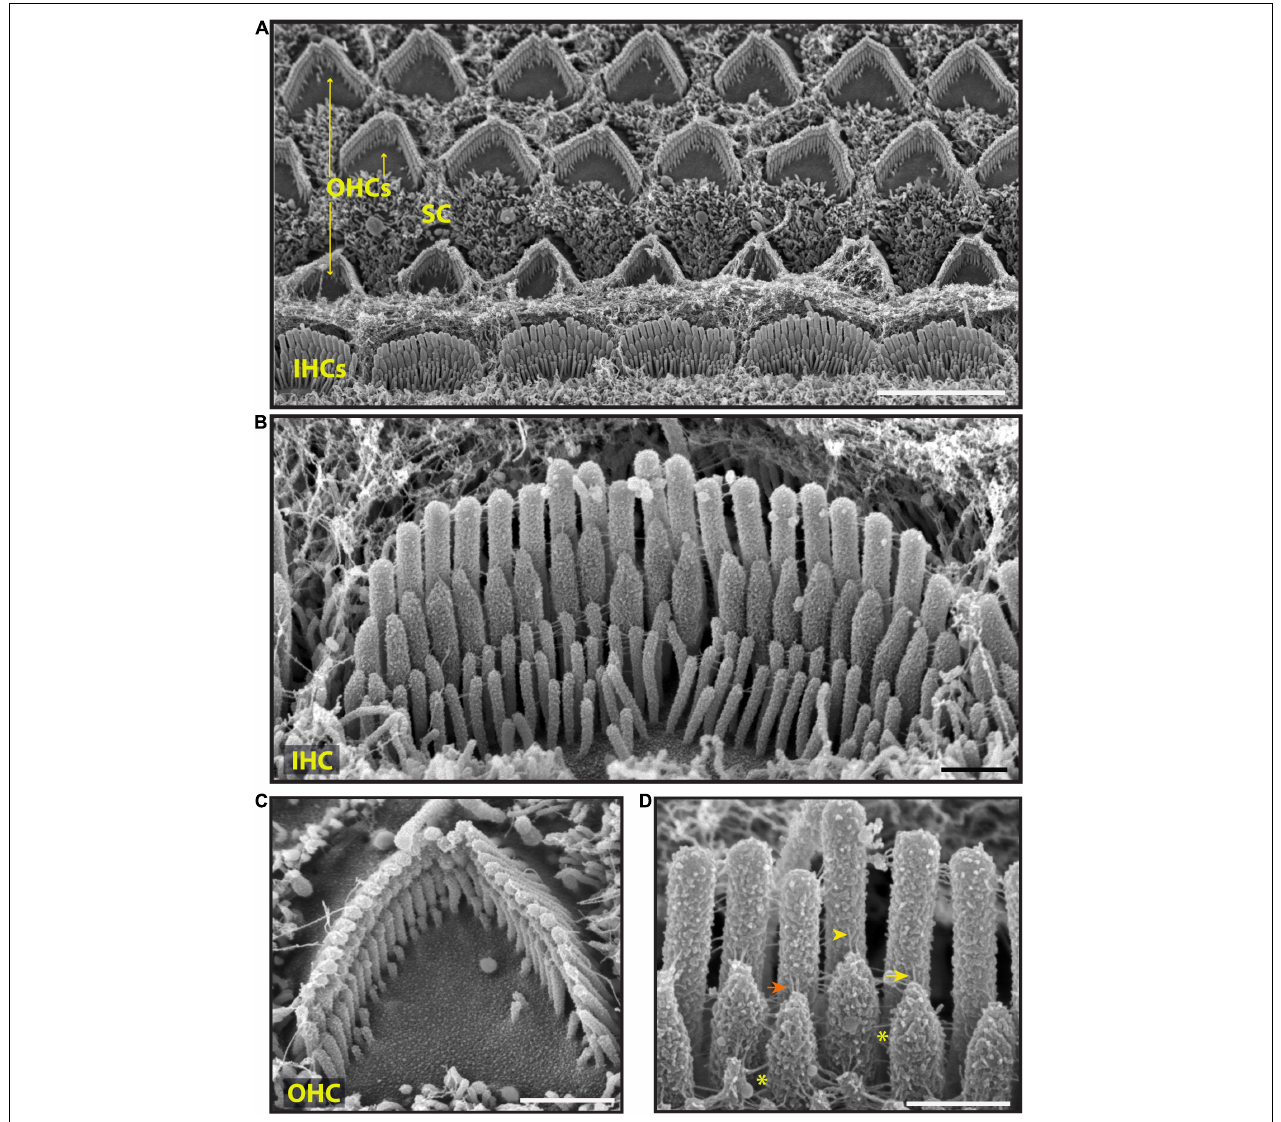
FIGURE 3 | Representative scanning electron micrographs of hair bundles of the neonatal (P5) wild-type mouse cochlea. (A) Low magnification micrograph shows an overview of the organ of Corti with three rows of OHCs (yellow arrows), one row of IHCs and supporting cells (SC). (B–D) High magnification micrographs of an IHC (B,D) and an OHC (C) bundles. Tip links connect the tips of adjacent stereocilia along the hair bundle’s axis of sensitivity. These include single tip link filaments (yellow arrow), forked tip links (yellow arrowhead), and “double” tip links from one stereocilium tip (orange arrow). Lateral links (yellow asterisks) spanning the gap between stereocilia are frequently observed. The surface of the stereocilia is rough suggesting the presence of a cell coat material. Samples were sputter-coated with 5 nm platinum and imaged with a field-emission SEM (Hitachi S-4700) using SE detection mode. Scale bars: (A) 5 µ m; (B,C) 1 µ m; (D) 500